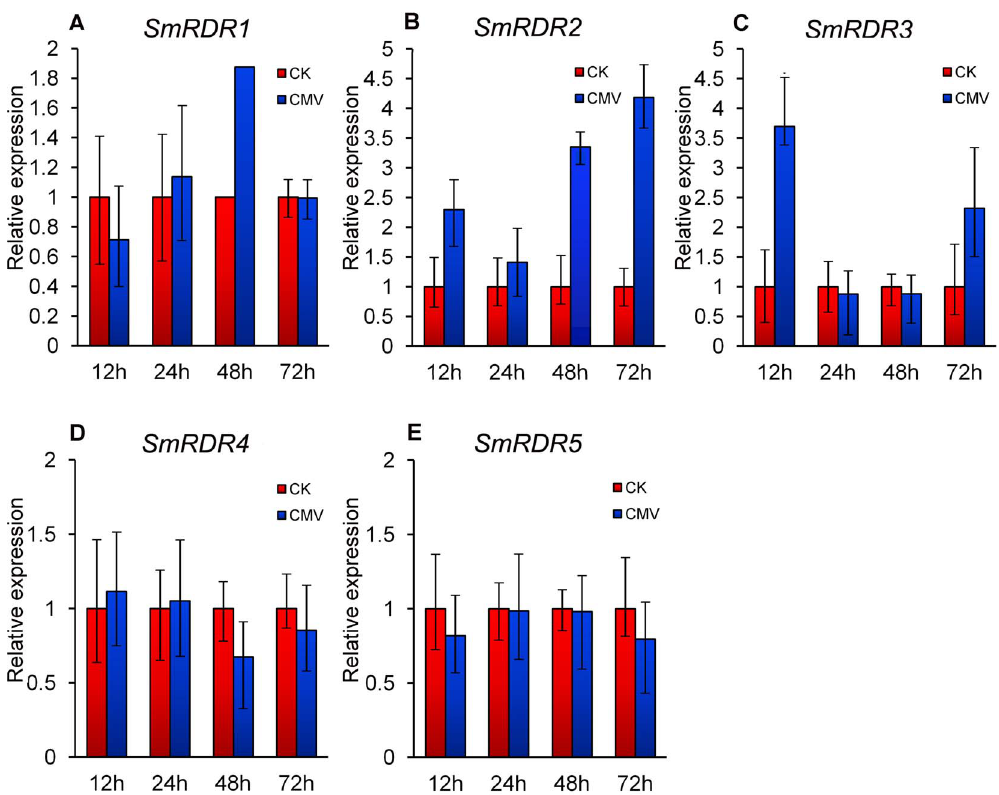
Figure 8. SmRDRs responsive to CMV infection. The expression patterns were analyzed using the quantitative RT-PCR method. PCR was carried out in triplicates for each biological sample. Three independent biological replicates were performed. SmUBQ10 was used as a reference. Fold changes of SmRDRs in leaves of S. miltiorrhiza plantlets infected with CMV for 12, 24, 48 and 72 h are shown. The level of transcripts in leaves inoculated with phosphate buffered saline (CK) was arbitrarily set to 1 and the level in tissues inoculated with CMV was given relative to this. Error bars represent standard deviations of mean value from three biological replicates.